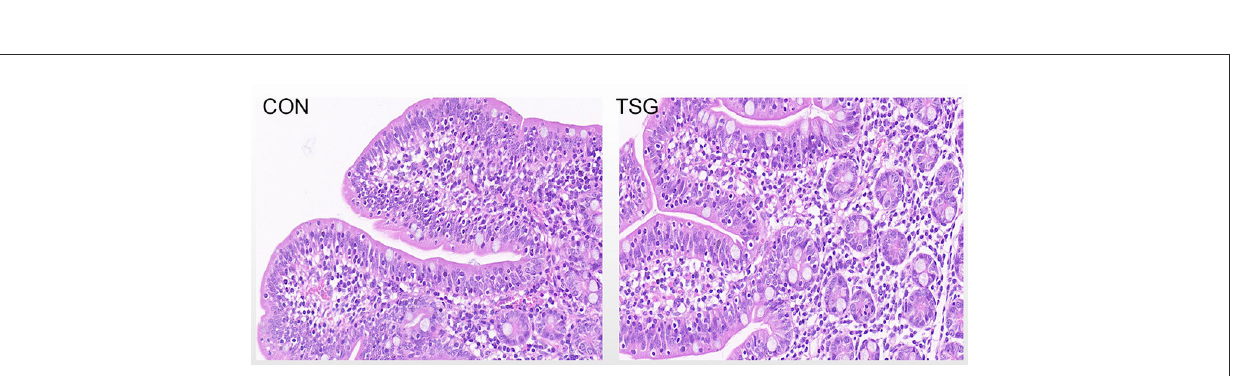
FIGURE2 The results of intestinal morphology. The jejunum tissues taken in the experiment were intestinal segments about 4cm after 5cm close to the proximal end. Hematoxylin and eosin staining with original magnification × 40.